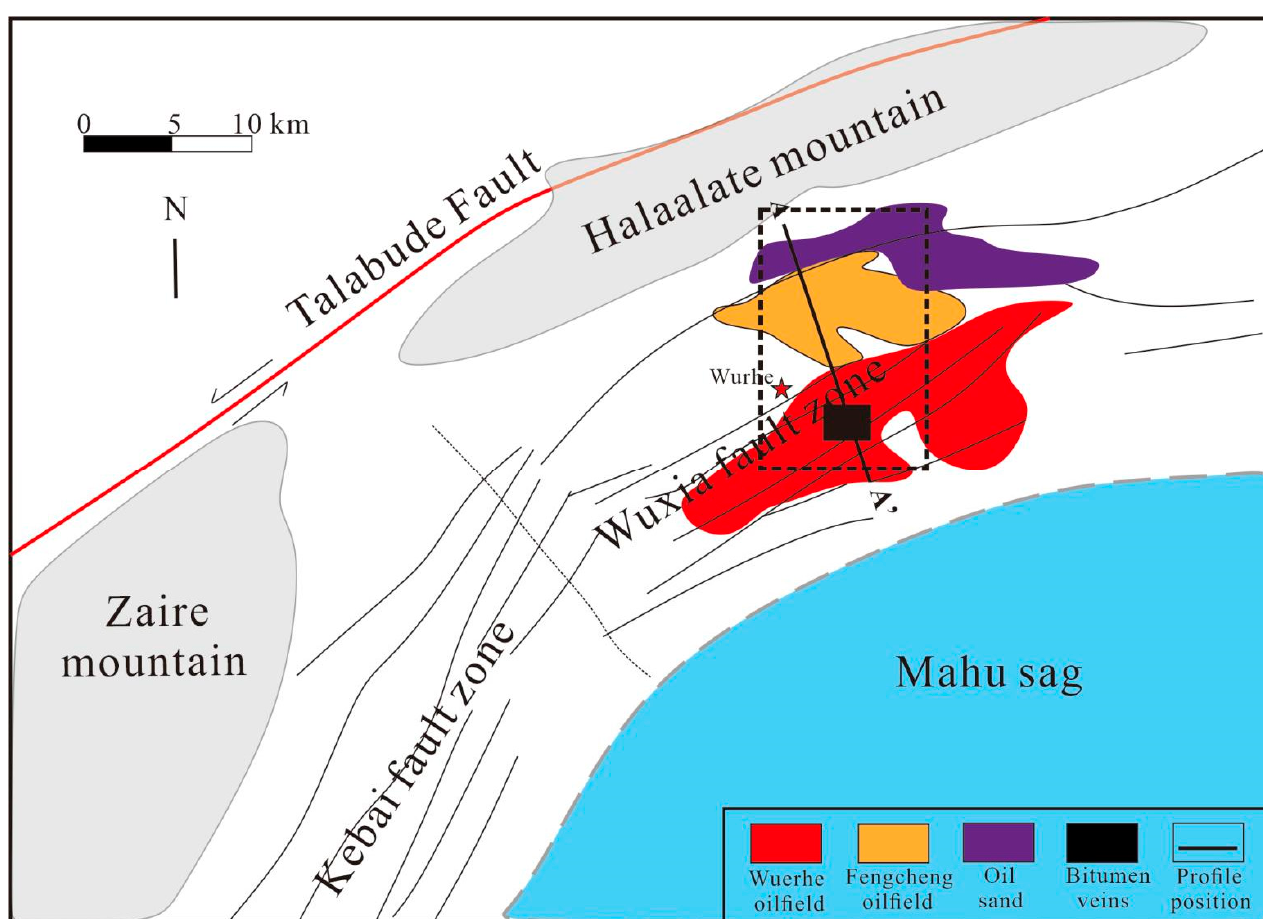
Figure 1. Structural location map of the research area, northwestern Junggar Basin.